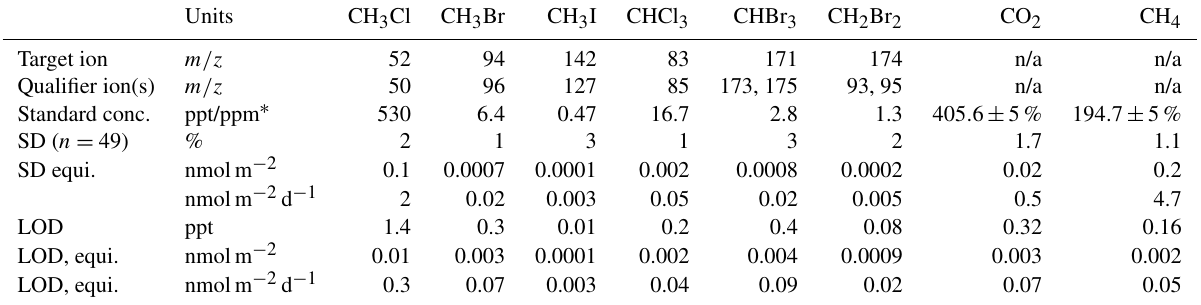
Table 1. The standard concentration, limit of quantification (standard deviation, SD), and limit of detection (LOD) for each gas analysed, with the target ion and qualifier ion(s) ( m/z ; mass/charge) shown for gases analysed by a GCMS. ∗ The units are parts per trillion for the halocarbons and parts per million for CO 2 and CH 4 . n/a – not applicable to the method of measurement. “equi.” is short for equivalent. Units CH 3